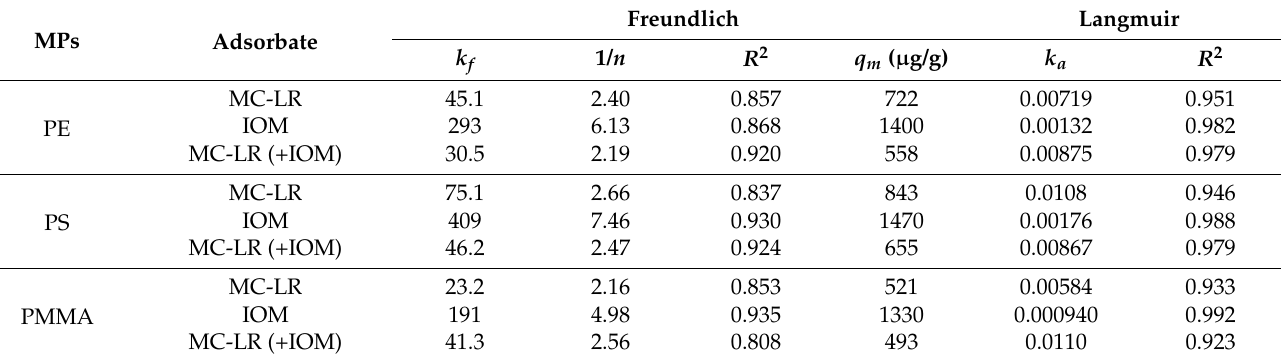
Table 2. Adsorption isotherm parameters of MC-LR and IOM on the studied